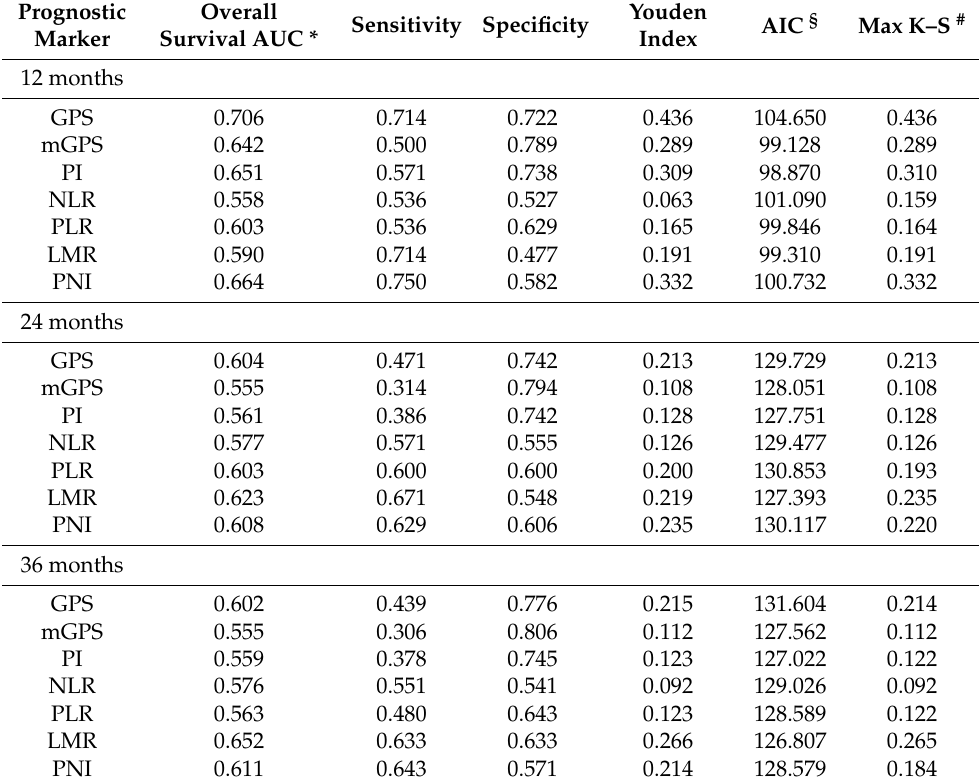
Table 4. ROC curves analysis of the inflammatory-based and nutritional prognostic